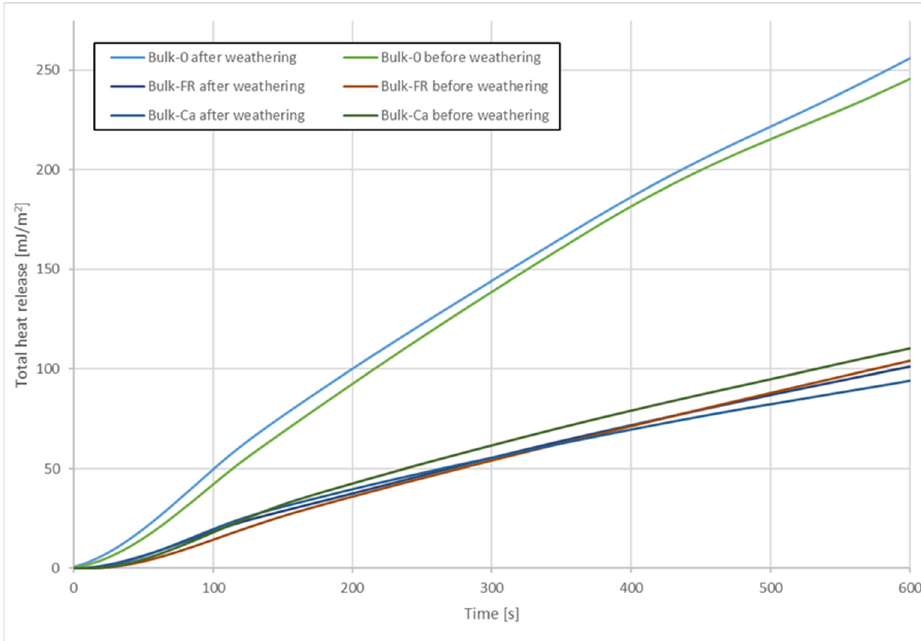
Figure 22. Total heat release for co-extruded formulations before and after weathering. 0: without any filler; FR: with FR CROS 490; and Ca: with calcium carbonate.